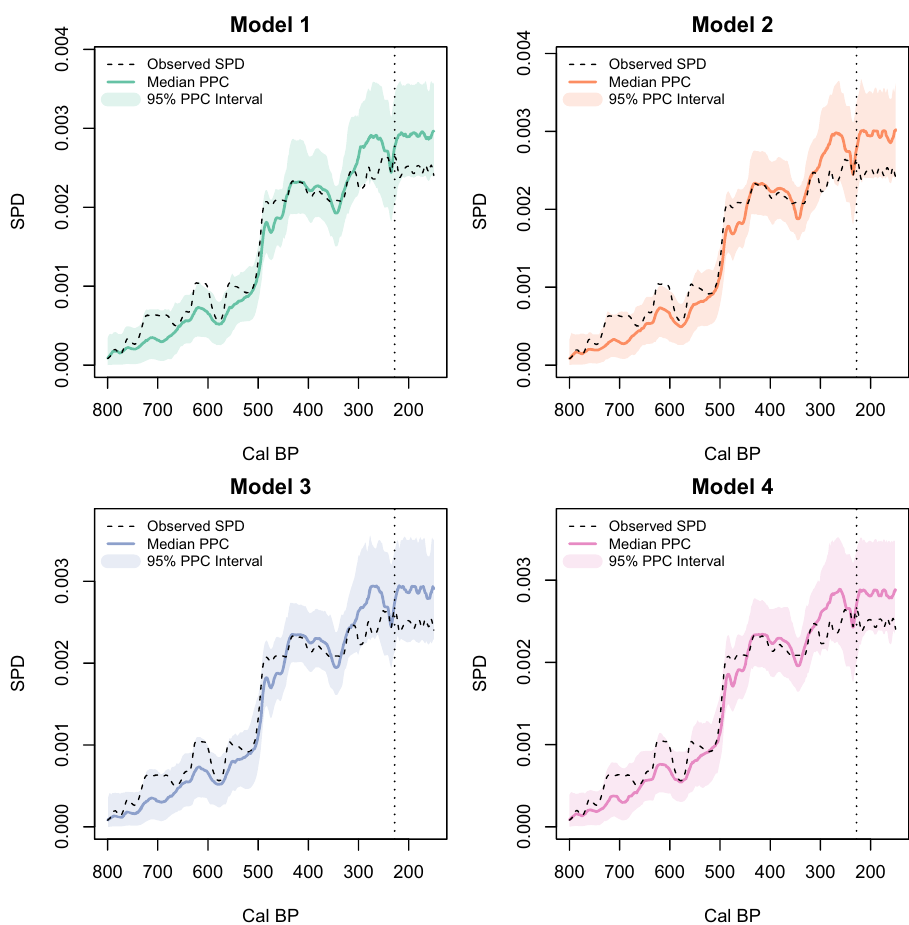
Fig. 4 Posterior predictive checks (PPC) of the four fi tted models against the observed Rapa Nui SPD. The dashed black line is the observed SPD. The solid color lines and shading show the median and 95% PPC interval for the fi tted models. Note that the observed SPD lies within the simulation envelope of each model and the results of the four models are nearly identical. The vertical dashed lines mark the timing of European arrival in AD